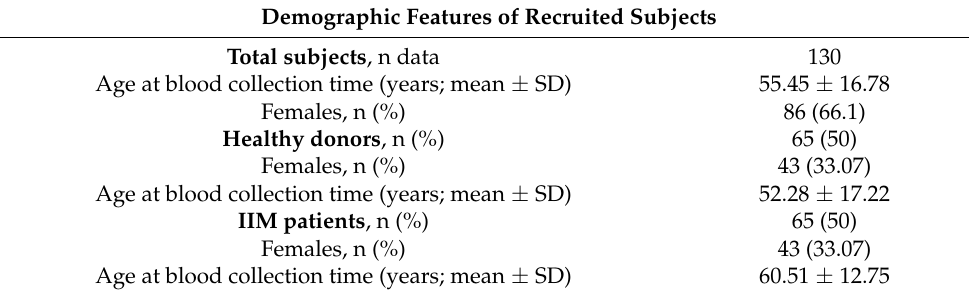
Table 1. Demographic features of the subjects enrolled in the study.